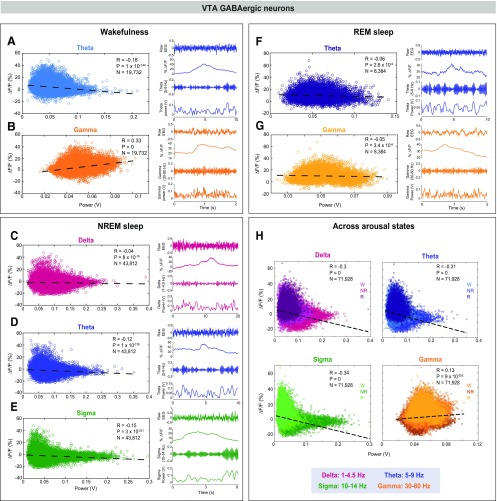
VTA-GABAergic population activity is positively correlated with fast-frequency EEG oscillations during wakefulness and negatively correlated with low-frequency oscillations during NREM sleep. Correlations between EEG spectral components and population activity during spontaneous wakefulness (A, B), NREM sleep (C–E), REM sleep (F, G), and across the three states (H). Each dot represents a 1-s epoch. Dashed line is the best linear fit. R is correlation coefficient. Right panels in each arousal state section represent a: representative raw EEG trace, fluorescence trace, filtered EEG, and power in a specific EEG band for a 2- to 10-s wake epoch.